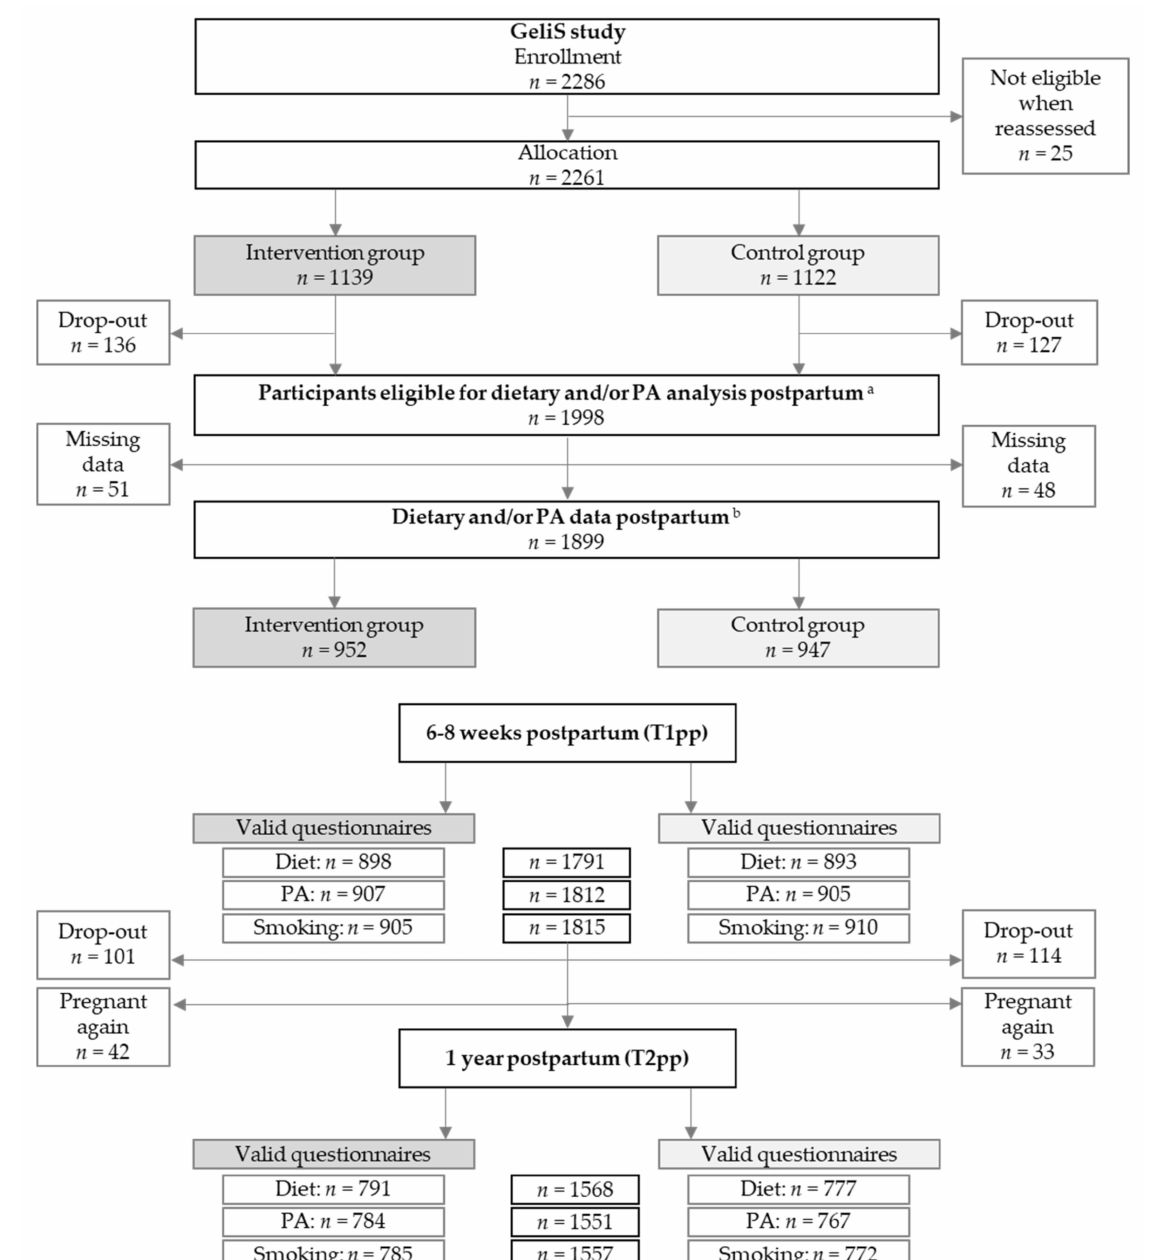
Figure 1. Flow of study participants. Abbreviations: T1pp: Assessment 6–8 weeks after delivery; T2pp: Assessment one year after delivery; PA: Physical activity. a Women who remained in the study until T1pp. b Women who provided PA and/or dietary data at T1pp or